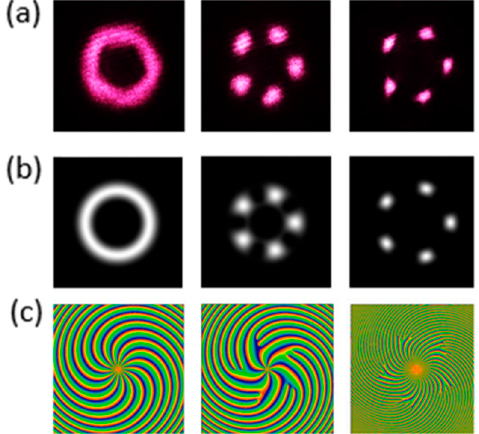
Figure 5. Passive Q-switching in an off-axis pumped Nd:YVO 4 /Cr 4+ :YAG laser (pump power 3.8 W, off-axis distance 0.55 mm). ( a ) Experimental results; ( b ) theoretically calculated results; and ( c ) theoretically calculated vortex optical phase structure.